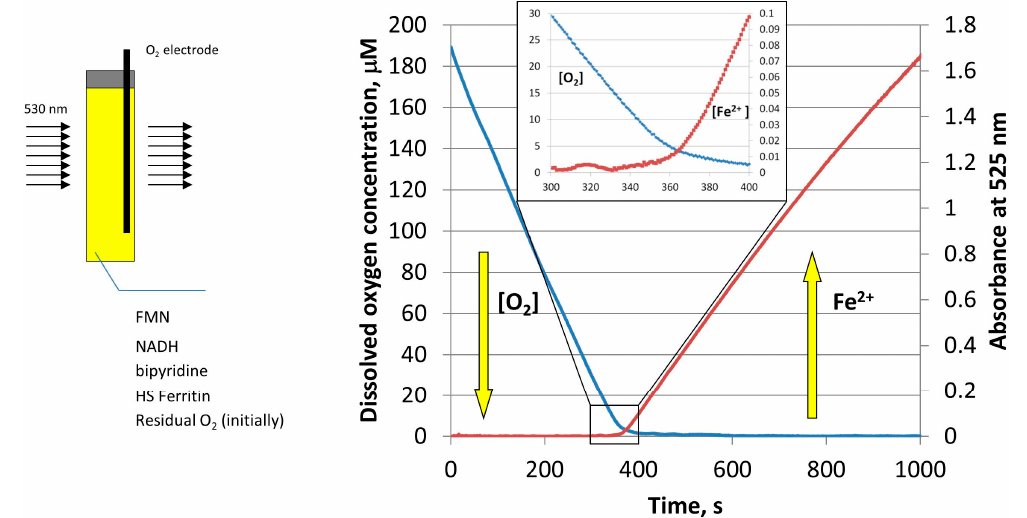
Figure 4. Schematic of the simultaneous monitoring of the dissolved oxygen concentration (blue curve), and light absorption of Fe(II)–bipyridine complex at 530 nm (red curve), during the reductive release of iron from HosF (0.6 μ M), in the presence of 2 mM NADH, 2 mM FMN, and 2 mM 2,2 ′ -bipyridine. Reprinted with permission from Ref. [23].